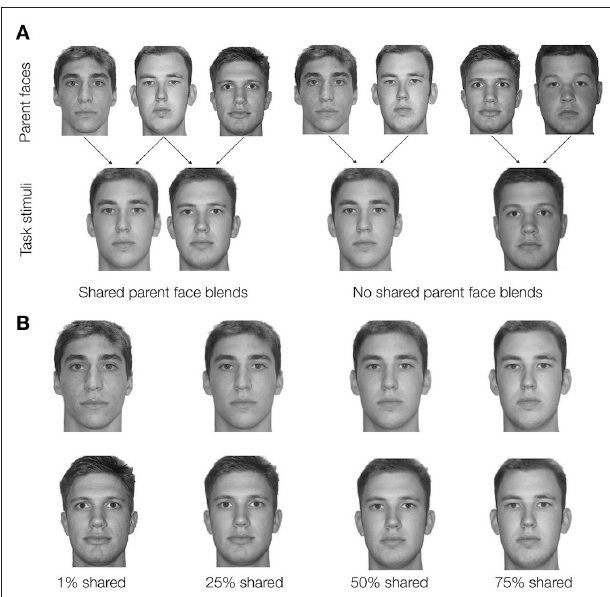
FIGURE 2 | (A) In Experiment 1, pairmate faces were blended to either share a parent face or have no shared parent face. Example unaltered parent faces (not shown during any phase of the experiment) are depicted in the top row. On the left, the faces are combined to make shared parent pairmates. On the right, a similar set of unaltered faces are blended to make no shared parent pairmates. Arrows indicate which parent faces would be blended to create task stimuli. All task stimuli in Experiment 1 were 50/50 blends of their parent faces. (B) In Experiment 2, all pairmate faces were blended with a shared parent face but the percentage of the shared parent face included in the final blend face varied parametrically (1%, 25%, 50%, or 75% shared parent). Here, an example Face 1 – Face 2 pair (the shared parent example from A) is shown at each of the four possible blend levels. The top row depicts an example Face 1 at each blend level. The bottom row depicts an example Face 2 at each blend level. In A and B , the same faces are shown for different levels of similarity to demonstrate how the blending process manipulates similarity. In the experiment, a given unaltered face would be part of only one Face 1 – Face 2 pairmate. All the faces depicted come from the Dallas Face Database ( Minear and Park,